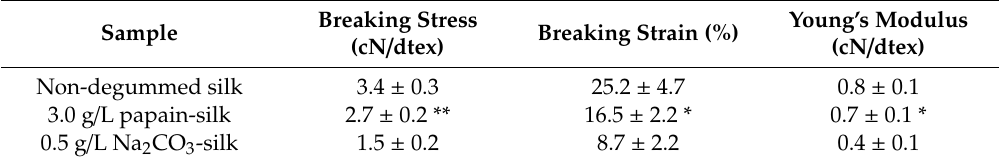
the silk fiber after degumming [19,52,53]. In this study, the silk fibers were degummed with a